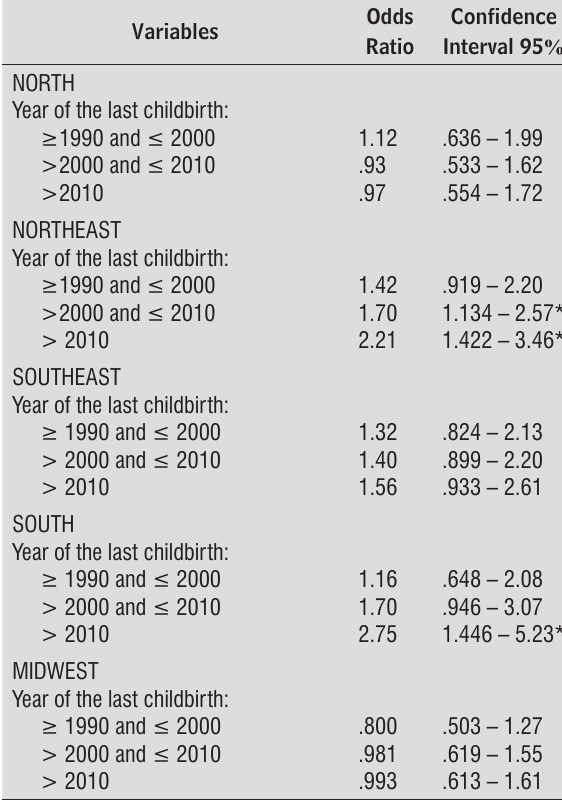
Table 2 - Association of cesarean section over the years in Brazilian regions (n = 16.175, Brazil, 2013) Variables